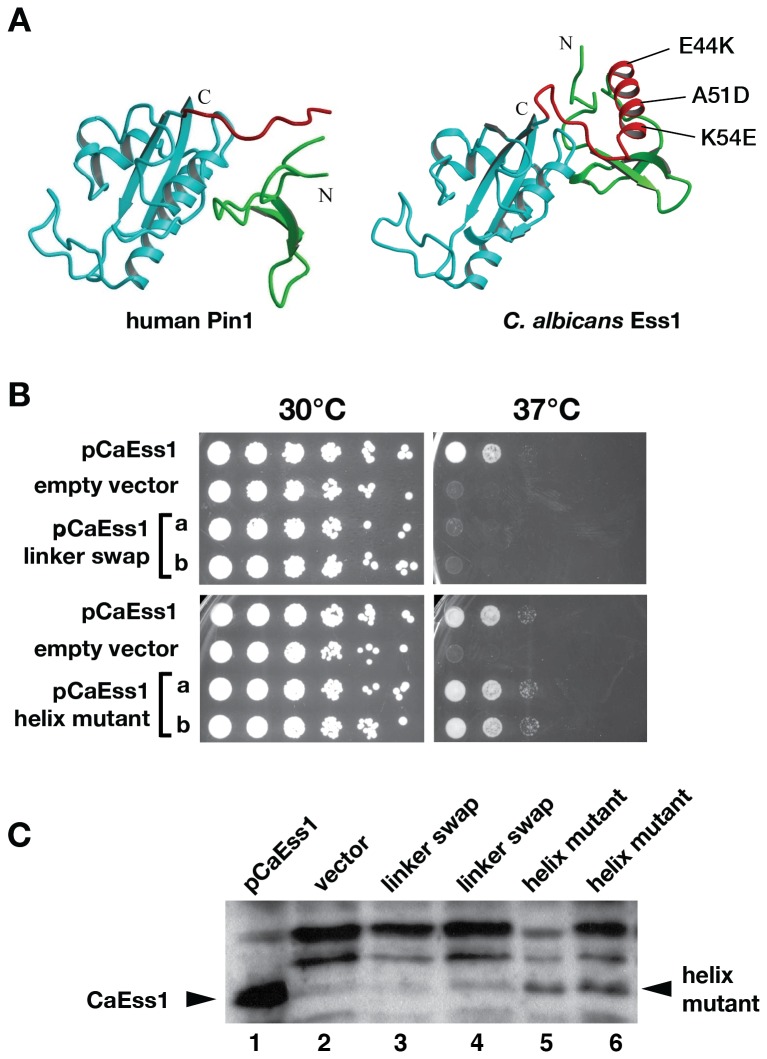
Structure-function analysis of CaEss1.(A) X-ray crystallographic structure of the human homolog, Pin1 [40] and CaEss1 [50]. Substitutions made in the structured linker α-helix of CaEss1 to construct the helix mutant (hm) strains are indicated. (B) Complementation of CaEss1 linker mutants in S. cerevisiae. Plasmids encoding the indicated mutant proteins (independent clone isolates of linker-swapped plasmid, pDS426(sw) and helix substitution plasmid, pDS426(pm)) were separately transformed into a ts-mutant strain of S. cerevisiae (Scess1H164R) [42]. Plasmids were constructed using a pRS426 backbone [88]. Serial dilution assays (1∶5) shows the growth of these independent transformants (a, b). Growth at 37°C, the restrictive temperature for the S. cerevisiae ess1 mutant, indicates complementing activity. The CaEss1 helix substitution mutant complements but the linker swap mutant does not. pGDCaEss1 [52] (pRS426 backbone) was used as a positive control and pRS426 [88] was used as an empty vector control. (C) Western analysis of whole cell extracts of S. cerevisiae expressing the indicated CaEss1 proteins. A total of 15 µg of protein was used per lane and the blot was probed using anti-CaEss1 polyclonal antibody at a 1∶500 dilution. For the mutant strains, two independent clone isolates of pDS413(sw) (lanes 3 and 4) and pDS413(pm) (lanes 5 and 6) were transformed into S. cerevisae and analyzed. Plasmids were constructed using a pRS413 backbone [88]. The S. cerevisiae strain used (CBW22; [44] does not express endogenous Ess1 protein but is viable due to a suppressor mutation (ess1Δsrb10Δ). The linker-swapped protein appears to be absent, or present at a very low level compared to the vector control, while the helix mutant protein is easily detected. pGD-CaESS1 (pRS413 backbone) encoding the wild-type protein (Devasahayam and Hanes, unpublished) was used as a positive control, and pRS413 was used as the empty vector control.